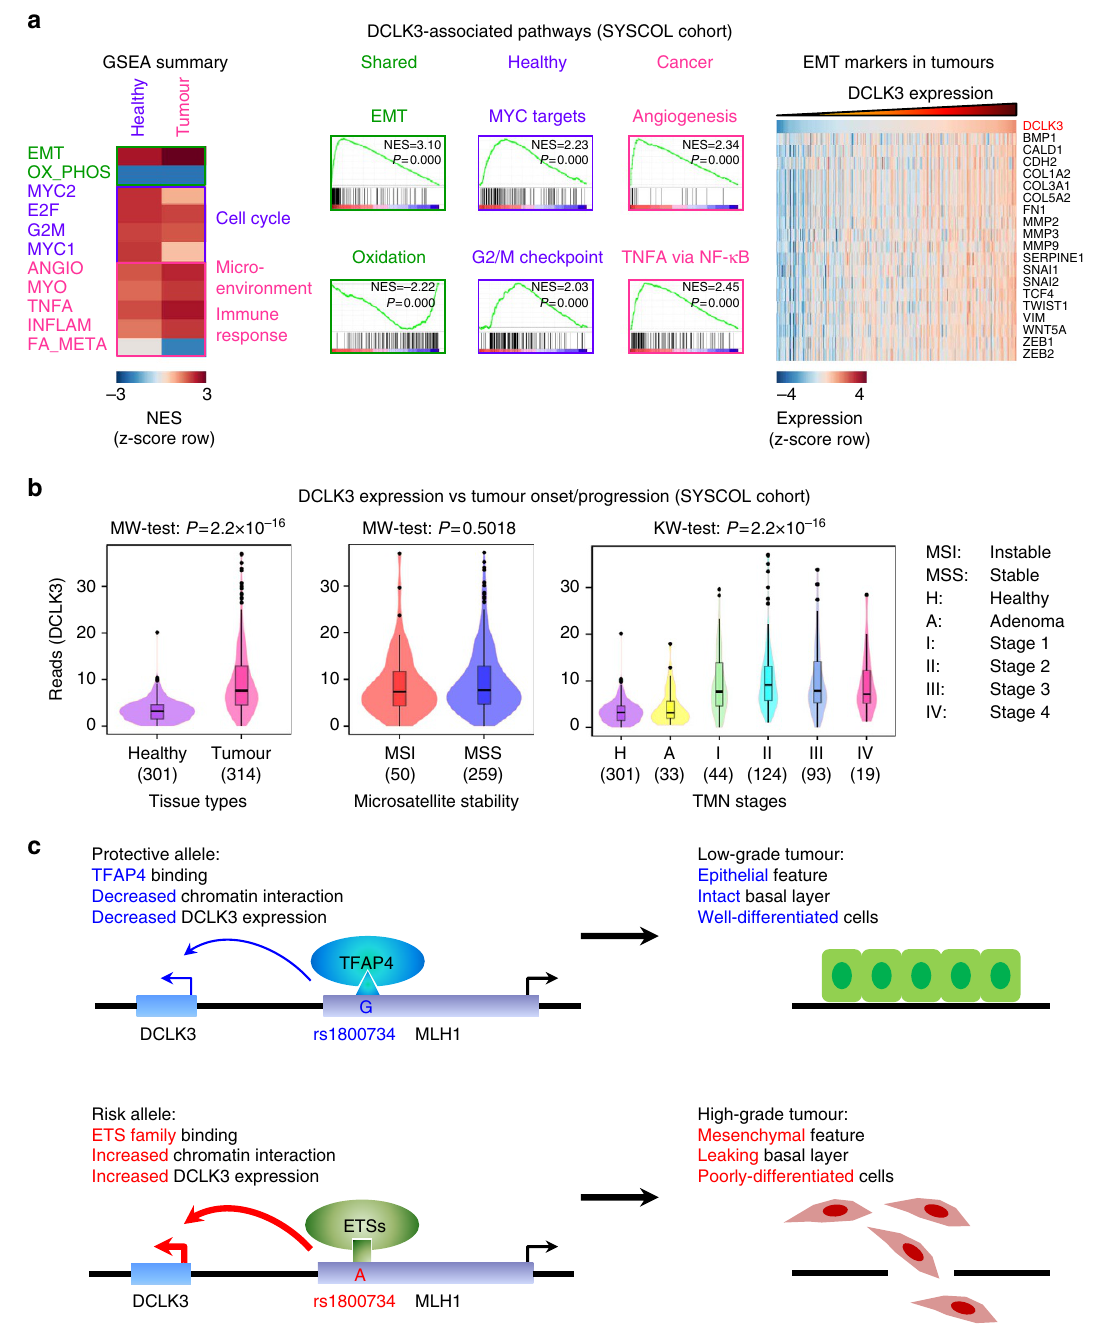
Figure 4 | Identification of DCLK3-associated gene sets and clinical parameters in the SYSCOL RNA-seq cohort. ( a ) GSEA analysis revealed DCLK3 correlated cancer hallmark gene sets. EMT and oxidative phosphorylation-associated gene sets were highly significantly associated with the DCLK3 expression in both healthy and tumour tissues. In addition, some DCLK3-associated gene sets showed healthy or tumour tissue specificity ( P -values were calculated in GSEA based on Pearson’s correlation). The expression of key EMT markers showed good correlation with the DCLK3 expression. ( b ) The DCLK3 expression was preferentially elevated in the tumours and especially the malignant tissues. However, we did not observe a clear difference between MSI and MSS tumours ( P -values: Mann–whitney U -test (MW test) and Kruskal–Wallis test (KW test)). ( c ) A proposed model describing how rs1800734 modifies the risk of CRC malignancy. TFAP4 and ETS family members specifically bind to the protective G- or risk A-allele, respectively. The rs1800734-ETS interaction increases the enhancer activity of the rs1800734 locus and enhances the expression of DCLK3 through an increased chromatin interaction. Cancer cells with the elevated DCLK3 expression undergo EMT and therefore metastasize to distal